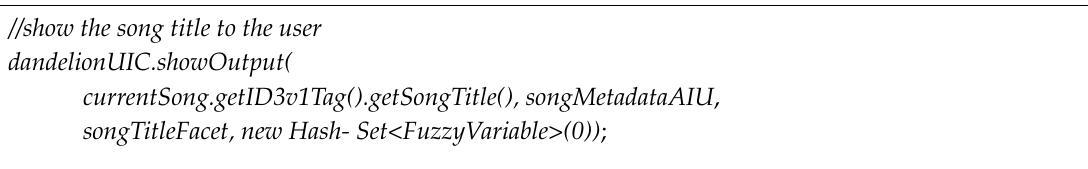
Algorithm 3. UI Control Logic code required to output the song title string to the user. It is executed each time the song